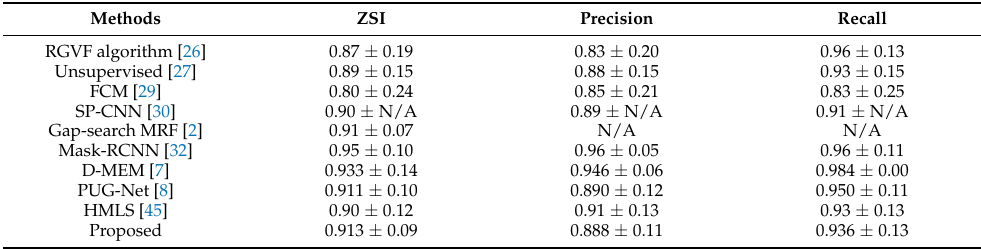
Table 2. Comparison of our proposed method with state-of-the-art methods specially designed for cervical cell nuclei segmentation. The values are in the format of µ ± σ